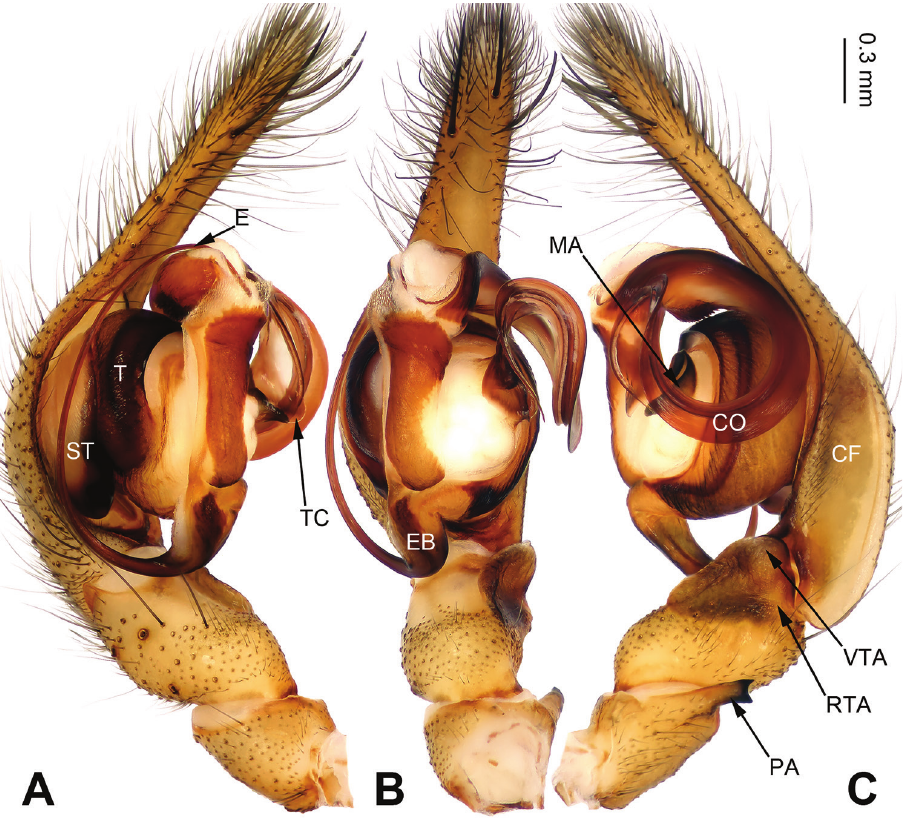
Figure 9. Palp of Pireneitega xiyankouensis sp. n., male holotype. A Prolateral view B Ventral view C Retrolateral view. Scale bar: equal for A, B,